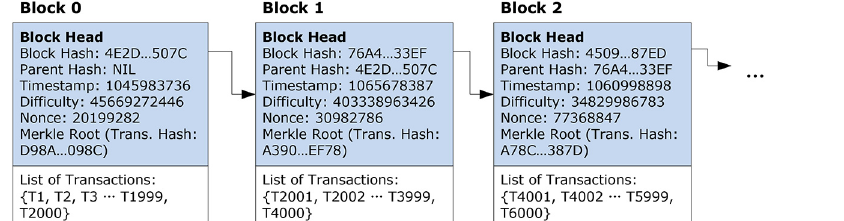
Figure 4. Blockchain data sample